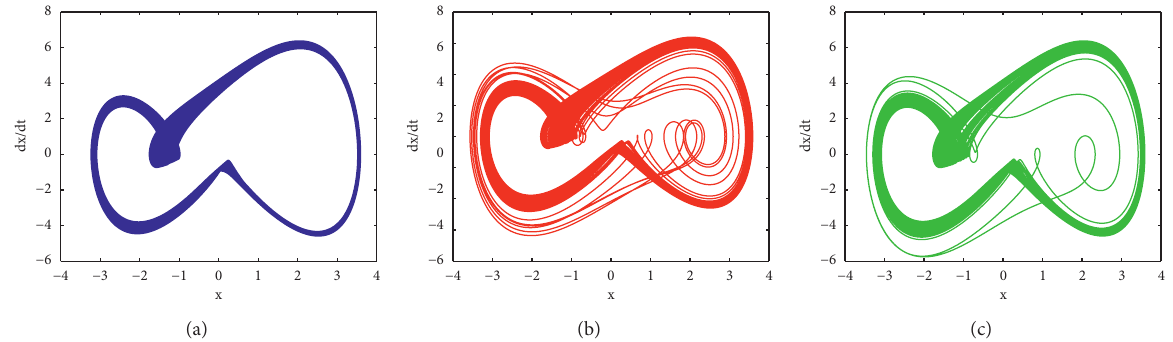
Figure 7: Phase portraits showing the coexistence of three different chaotic attractors for f � 7 . 9 under three initial conditions: (a) ( 0 . 5 , 0 . 5 ) , (b) (− 0 . 5 , − 0 . 5 ) , and (c) (− 0 . 8 , 0 ) .